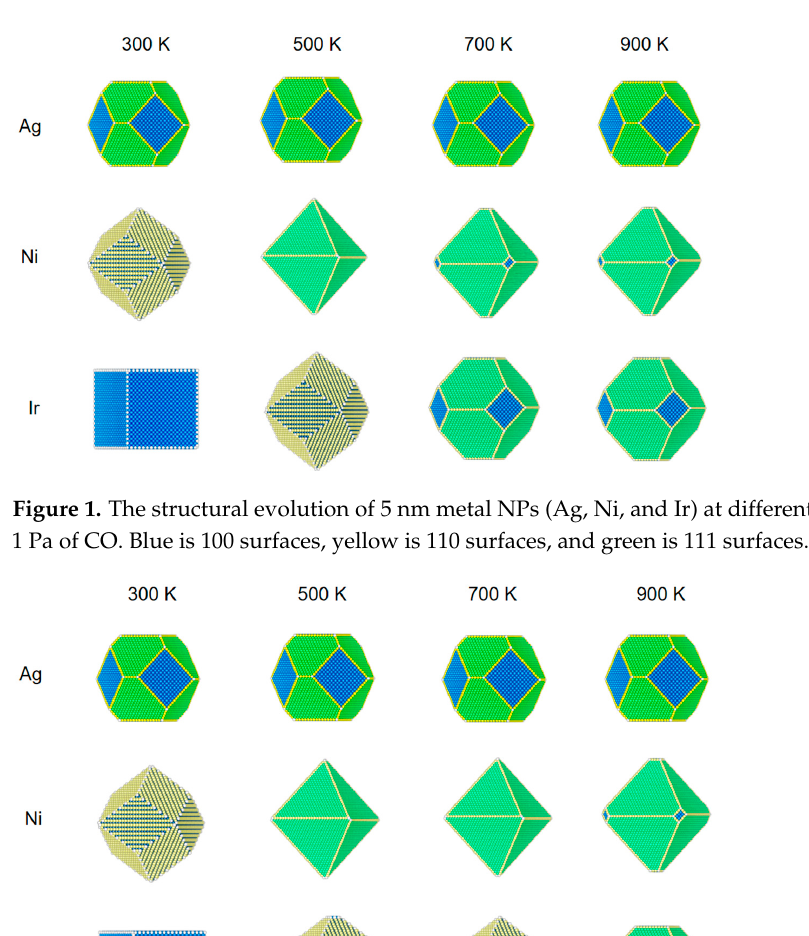
Figure 2. The structural evolution of 5 nm metal NPs (Ag, Ni, and Ir) at different temperatures and 100 Pa of CO.